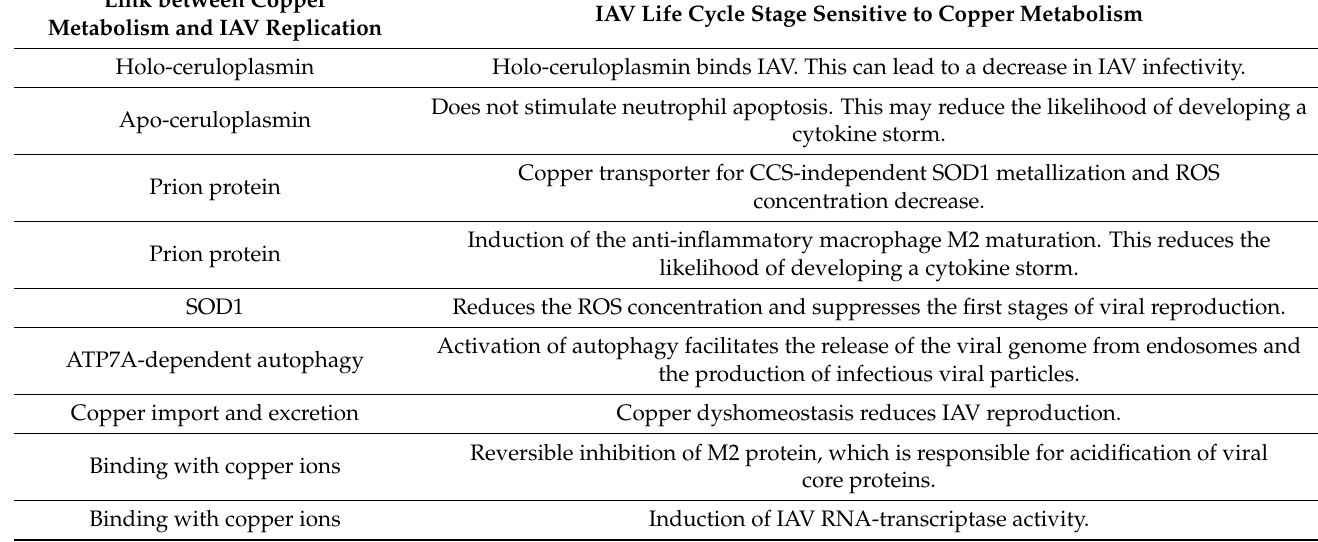
Table 1. The potential relationships between copper metabolism and IAV replication. Link between Copper